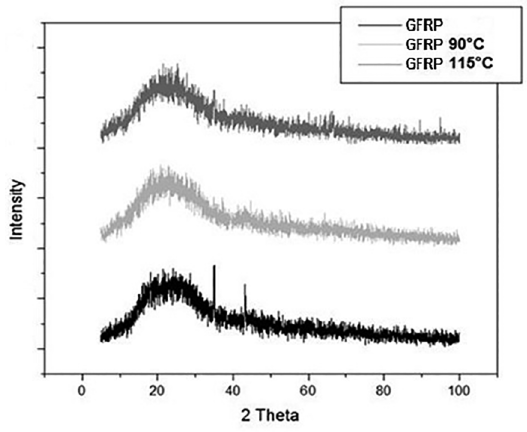
Figure 6. X -ray spectrum for the GFRP composite samples. FTIR analysis was performed on ethanol, Figure 7, to observe the existence of characteristic functional groups of this solvent in the spectra obtained for the polymer materials